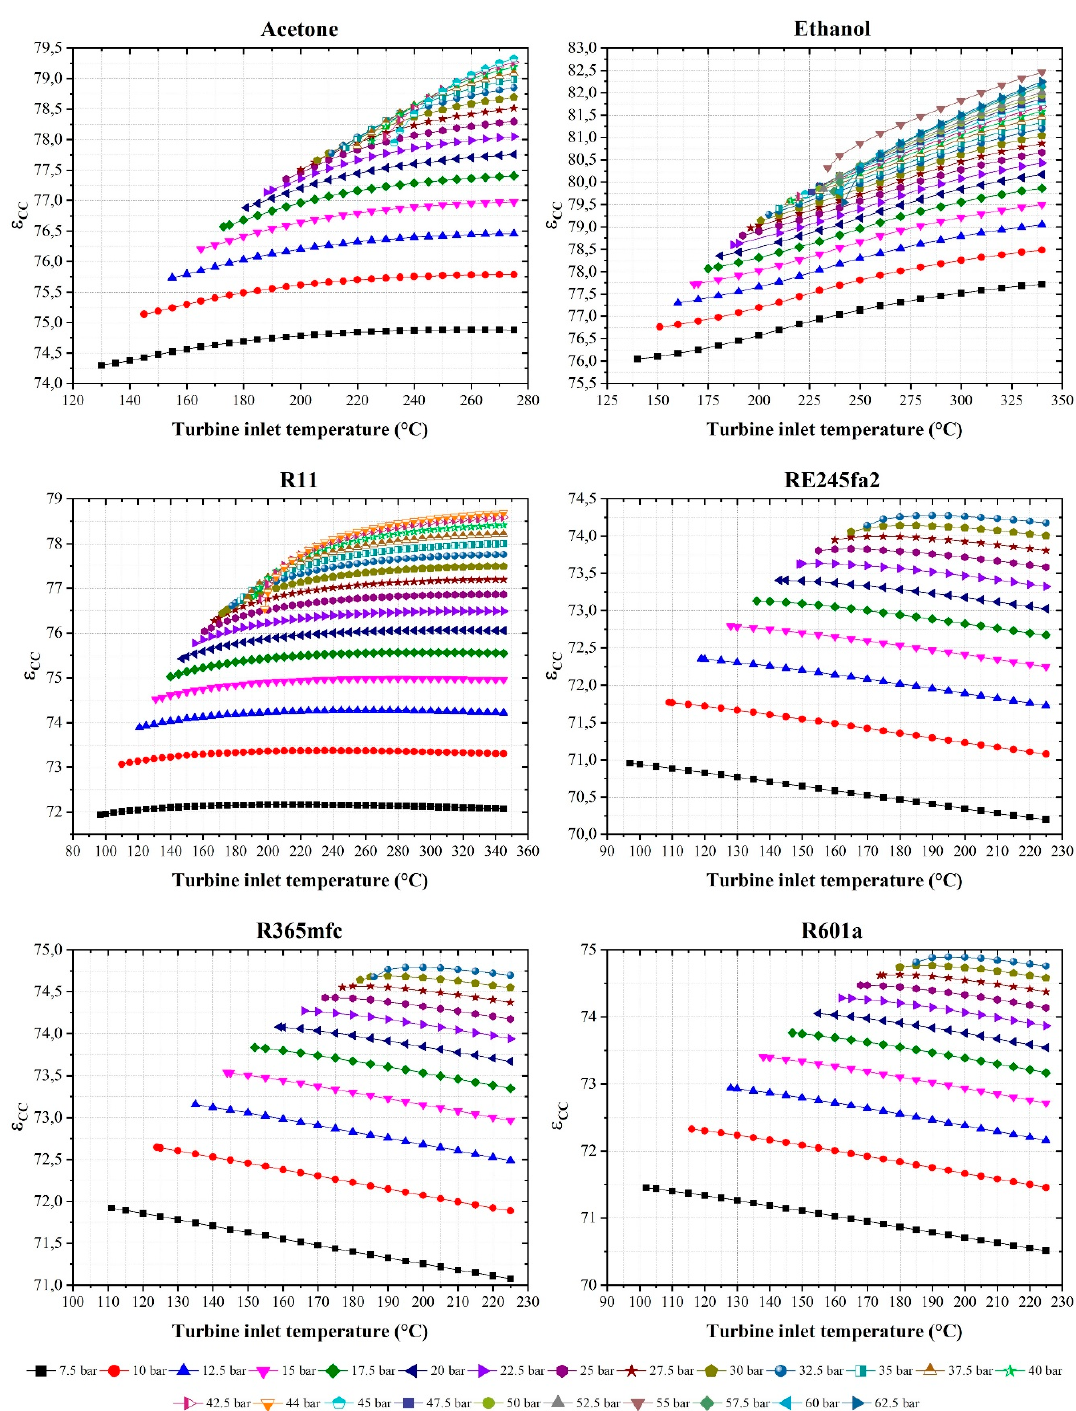
Figure 10. The change in exergy e ffi ciency of the cogeneration cycle by considering the selected organic working fluids, ORC-turbine inlet temperature and ORC-turbine inlet